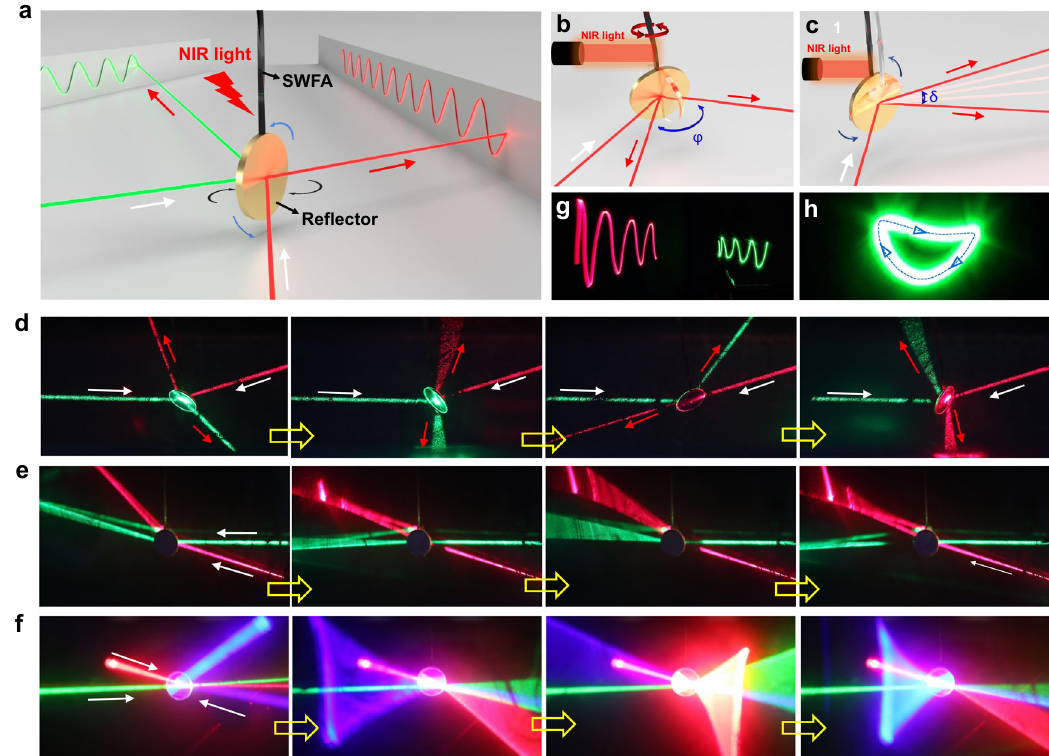
Fig. 5 Laser modulation. a Schematics showing the experimental setup of a laser steering system. Phototunable self-oscillations are used to control the periodic motion of the re fl ector, which is utilized to adjust the re fl ection direction of laser beams. b , c Schematics showing the horizontal scanning range ( φ ) and vertical scanning range ( δ ), respectively. d Experimental photographs showing beam steering driven by rotational oscillation (Supplementary Movie 13). The re fl ection angle of the red and green laser beams was dynamically changed by the periodic rotation of the re fl ector. e Snapshots showing fast laser scanning driven by tilt oscillation (Supplementary Movie 14). Red and green laser beams were re fl ected and oscillated to generate fast scanning. f Snapshots showing 2D scanning of multiple laser beams using a complex oscillation (Supplementary Movie 15). The re fl ection direction of three laser beams (red, green, and blue laser beams) was dynamically changed by using the complex oscillation that combines rotational oscillation and tilt oscillation. g Sinusoidal trajectory of two moving laser spots. h Loop trajectory of a moving laser spot. The arrows indicate the moving direction of the laser spot. White and red arrows indicate the incident direction and re fl ection direction of laser beams,